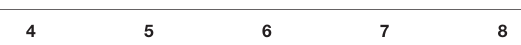
TABLE 1 | Means, standard deviations, and correlations with confidence intervals for the main study variables.